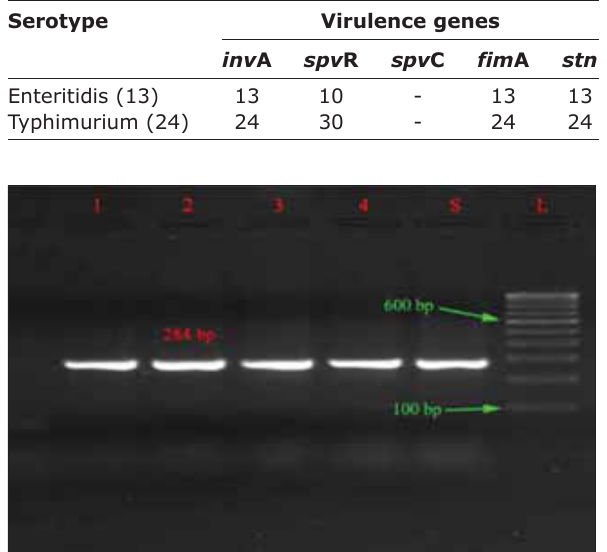
Figure-1: Agarose gel showing polymerase chain reaction amplification products of inv A gene (284 bp).